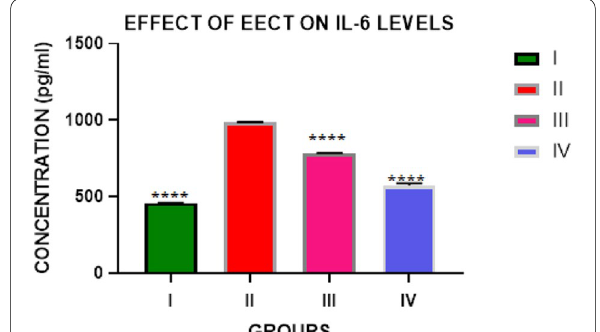
Fig. 5 Effect of EECT on IL-6 Levels